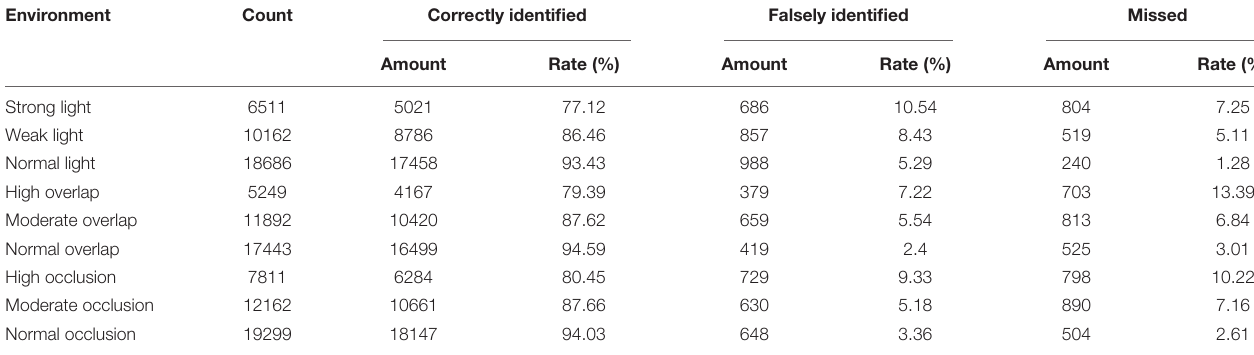
FIGURE 7 | Example of nine unstructured scenarios. TABLE 5 | Impact of different unstructured scenarios on the